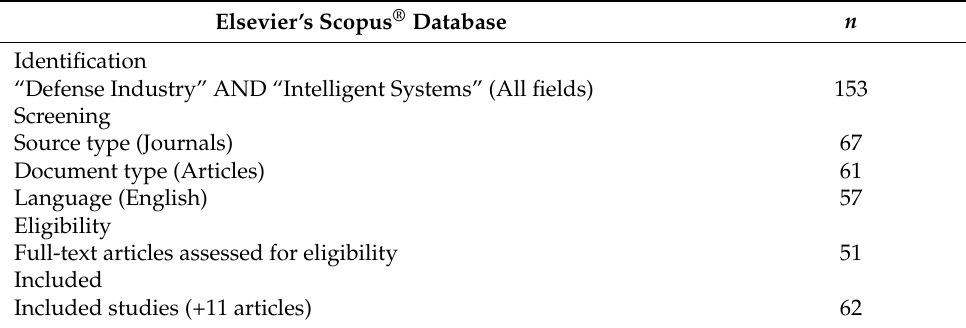
Table 2. Scopus search with PRISMA